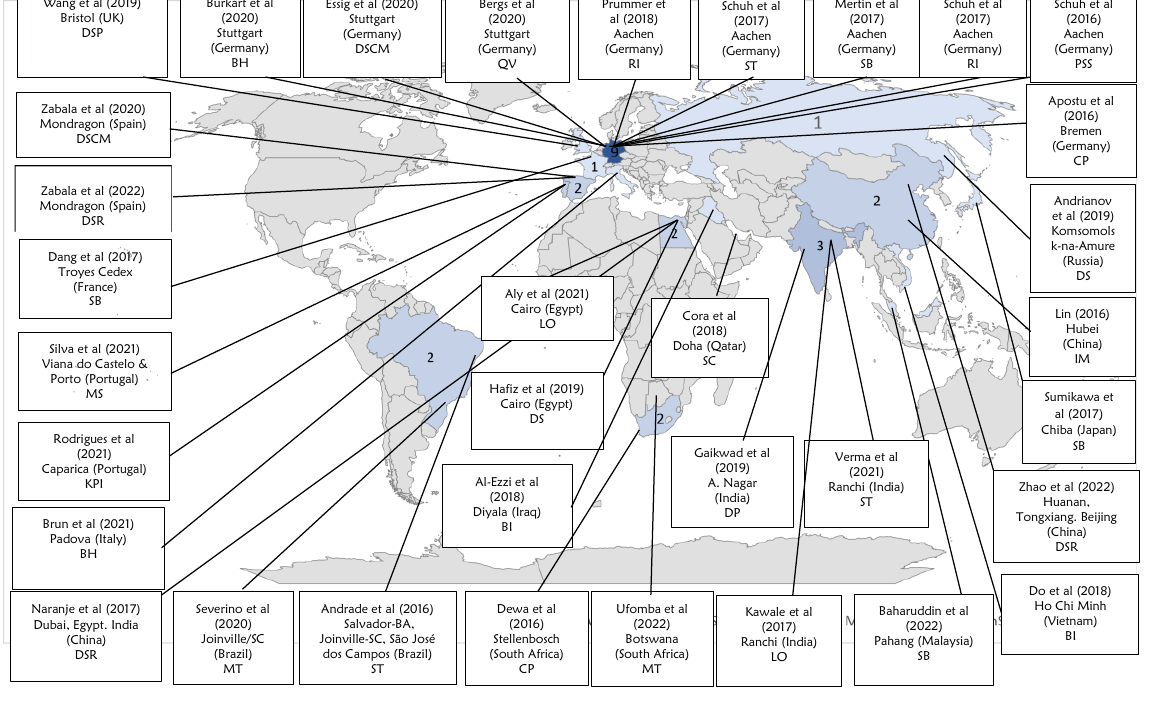
Figure 2: Research area mapping of studies related to stamping die manufacturing improvement.